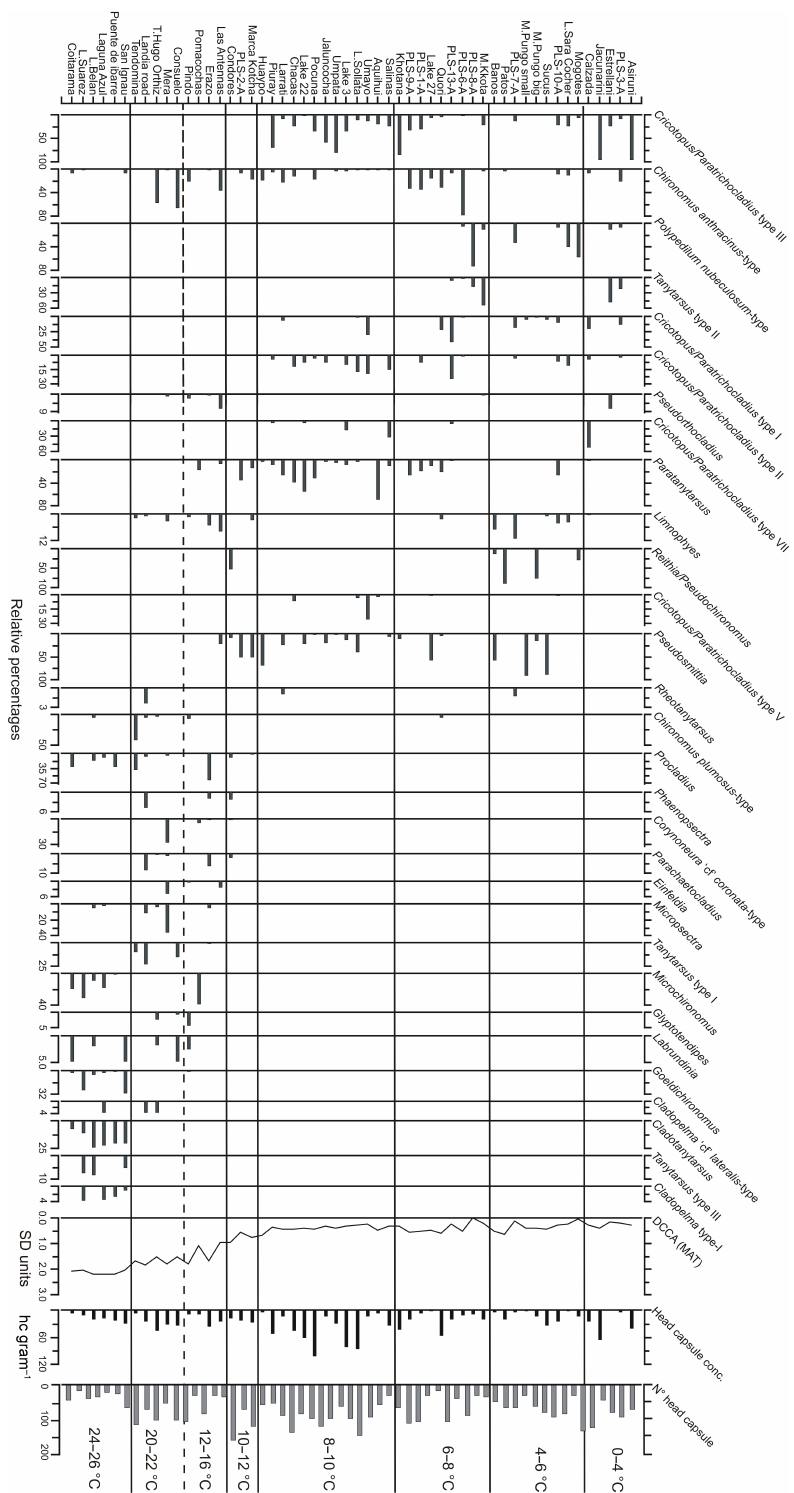
Figure 4. Chironomid taxa in the modern calibration data set lakes. Lakes are ordered (top to bottom) from cold to warm and chironomids are ordered by occurrence from cold to warm lakes. Only taxa present in three or more lakes are included. Dashed line shows a gap in calibration data set lakes between 16–20 ◦ C of the MAT gradient. Detrended canonical correspondence analysis (DCCA) constrained by MAT shows the taxon turnover across the gradient. Head capsule concentration (hcgram − 1 ) is also